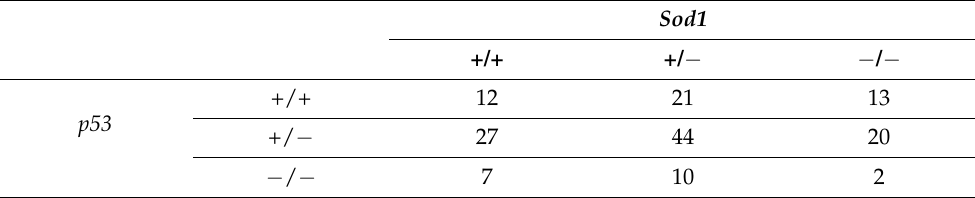
Table 1. The genotype of births to the cross-breeding between double-heterozygous mice. Sod1 +/+ +/ − − / − +/+ 12 21 13 p53 +/ − 27 44 20 − / − 7 10